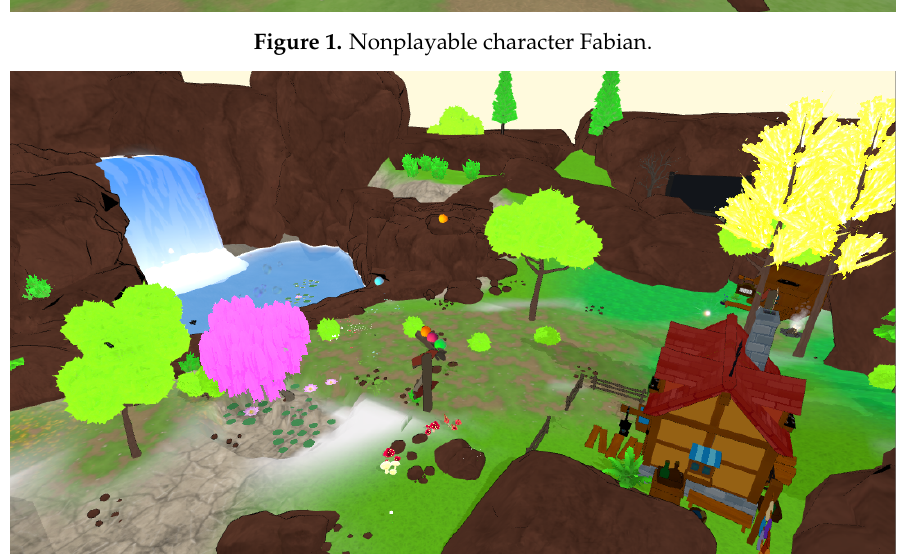
Figure 2. Bird’s-eye view of the SoundFields virtual